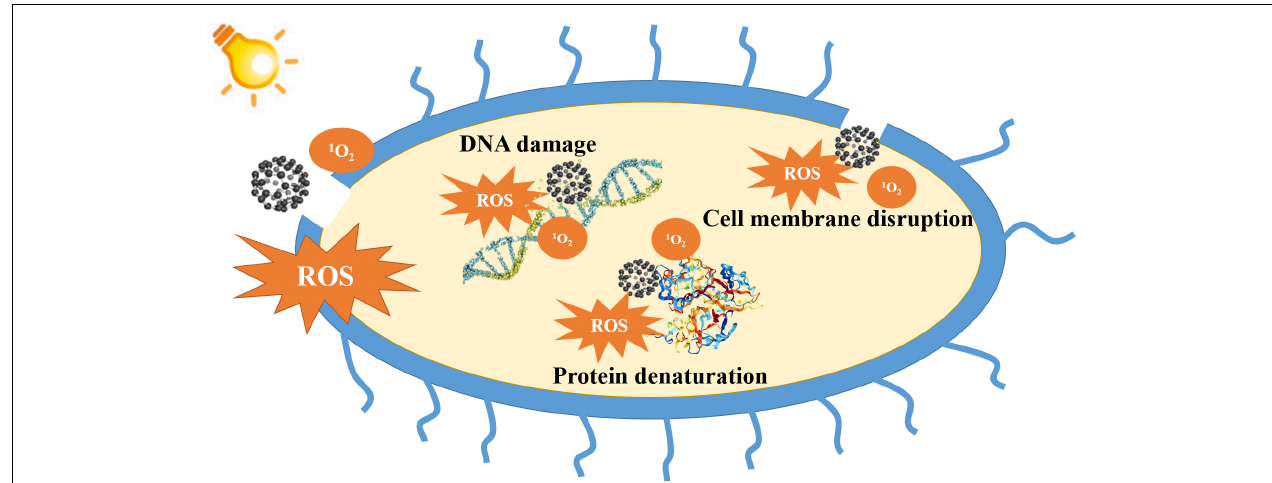
FIGURE 2 | Schematic representation of the photodynamic antibacterial mechanisms of fullerenes.